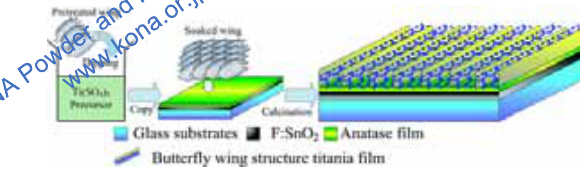
Fig. 16 Schematic Illustrations for the Transition Pro- cess of Butterfly Wings onto the FTO Glass Slices: Step 1, Soak the Butterfly Wings in the Titanium Sulfate Precursor; Step 2, Calcine the Soaked Butterfly Wings onto the Prepared An- atase Film on the FTO; Simplified Configura- tion of the As-Synthesized Quasi-Honeycomb Structure Photoanode Shown on the Right.